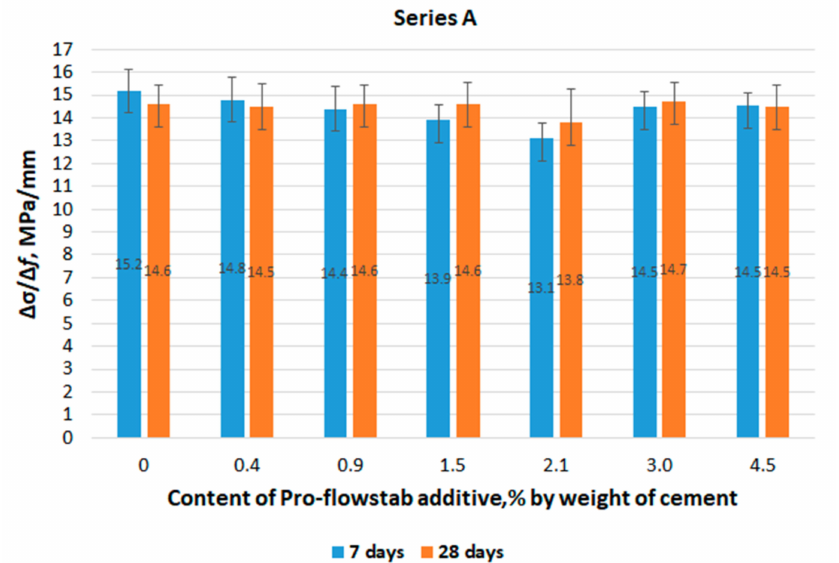
Figure 7. The value of the ratio ∆ σ / ∆ f in the bending test of series A specimens, depending on the age of the specimens and the Pro-Flowstab additive contents.